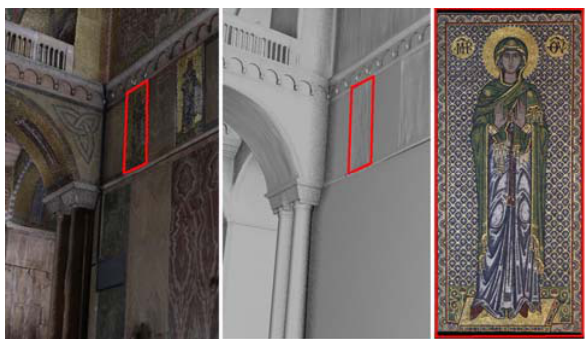
Figure 9: three products for the same area. From the left: textured mesh, NURBS model,